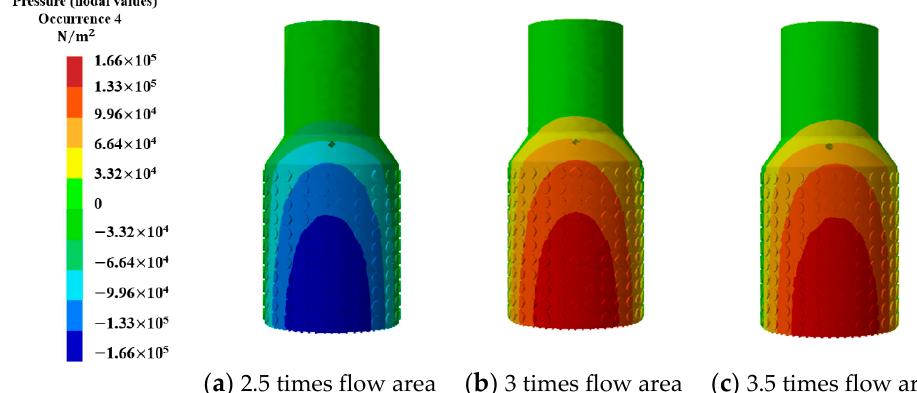
Figure 22. Third-order acoustic cavity modality.